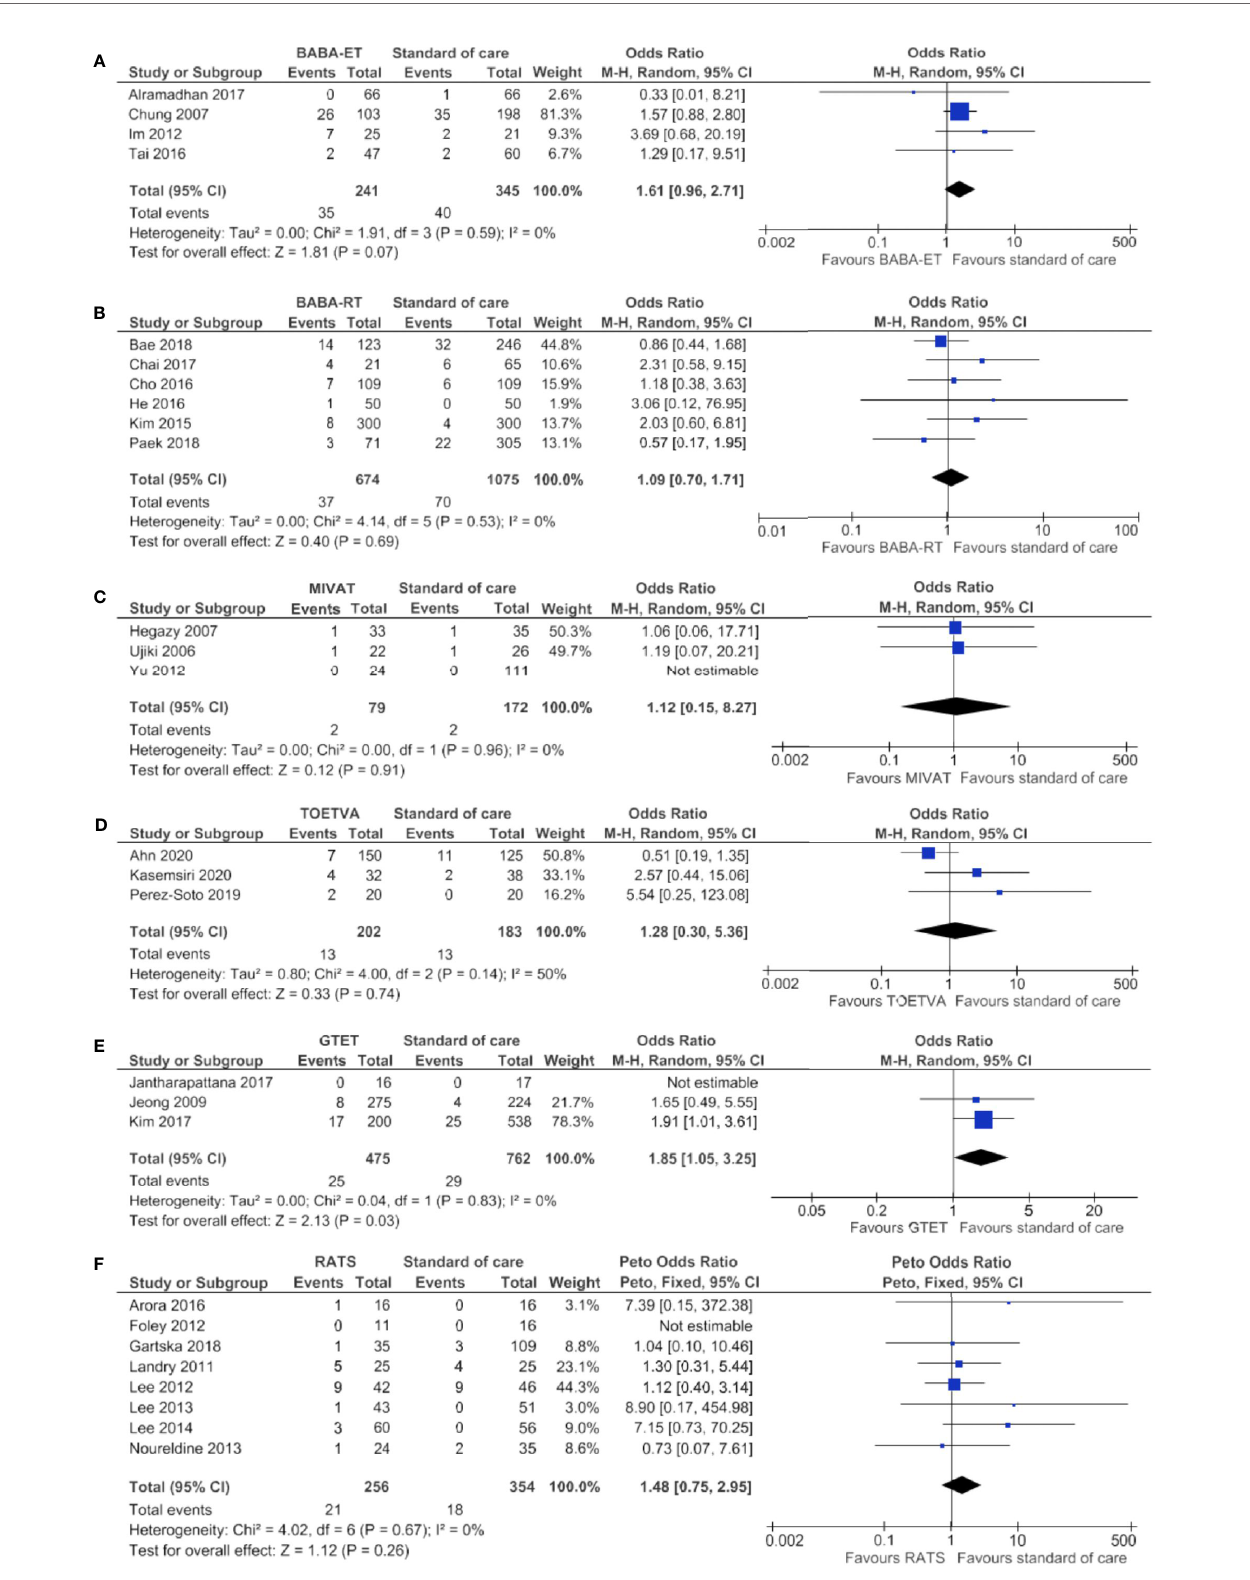
FIGURE 5 | Forests plots of transient recurrent laryngeal nerve injury for (A) BABA-ET, (B) BABA-RT, (C) MIVAT, (D) TOETVA, (E) GTET and (F)